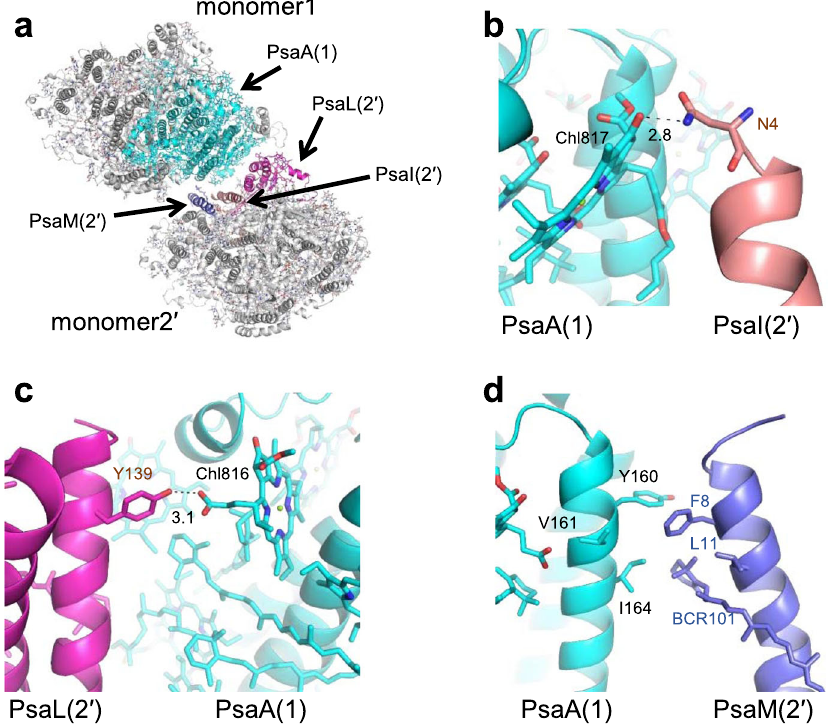
Fig. 4 Intermonomer interactions between monomer1 and monomer2 ′ . a Structure of monomer1 and monomer2 ′ from the PSI tetramer viewed along the membrane normal from the stromal side. b Interactions between monomer1-PsaA and monomer2 ′ -PsaI at the lumenal side. c Interactions between monomer1-PsaA and monomer2 ′ -PsaL at the lumenal side. d Interactions between monomer1-PsaA and monomer2 ′ -PsaM at the lumenal side.